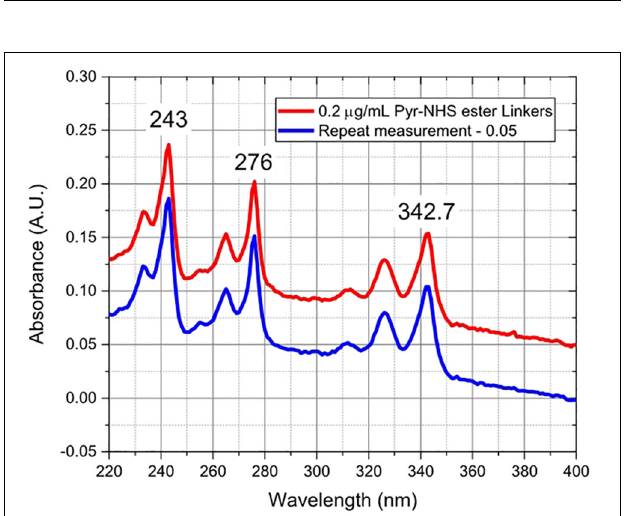
FIGURE 7 | Absorbance spectra of Pyr-NHS ester linker molecules at 0.2 µ g/mL concentration (red curve) and a repeat measurement (blue curve) off-set by 0.05 for clarity, showing the characteristic triple peaks due to the presence of pyrene moiety.